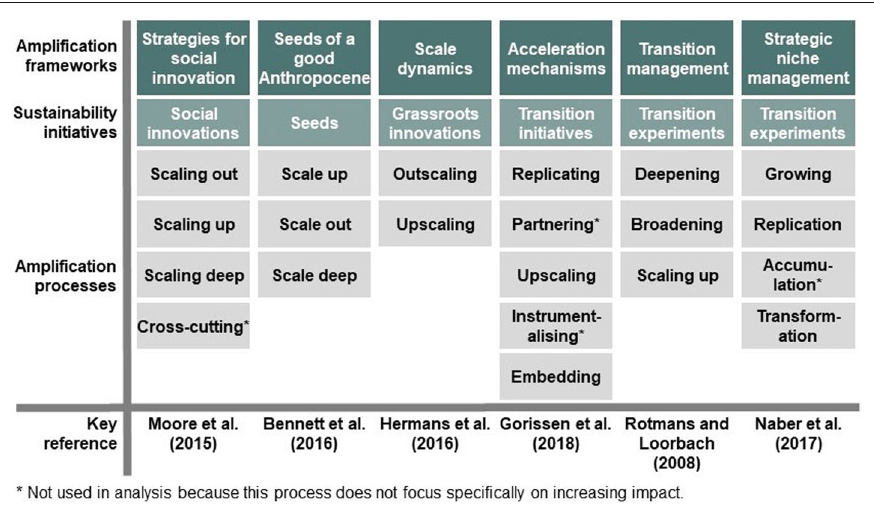
Fig. 1 Overview of amplification frameworks used in sustainability transformation research and their conceptualization of sustainability initiatives and amplification processes. Note that these are examples